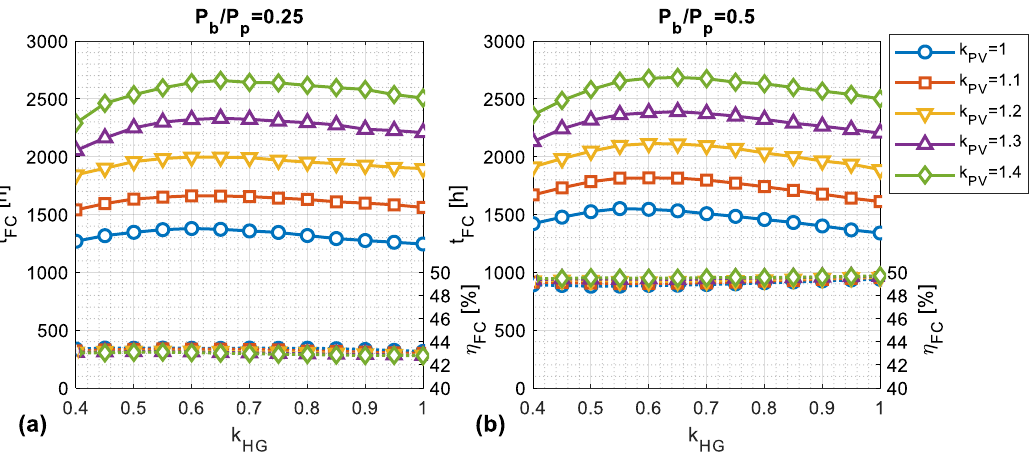
Figure 7. Energy sent to the hydrogen generator (solid lines) and average conversion efficiency (dashed lines) as a function of k HG and different k PV values for ( a ) P b /P p = 0.25 and ( b ) P b /P p = 0.5.